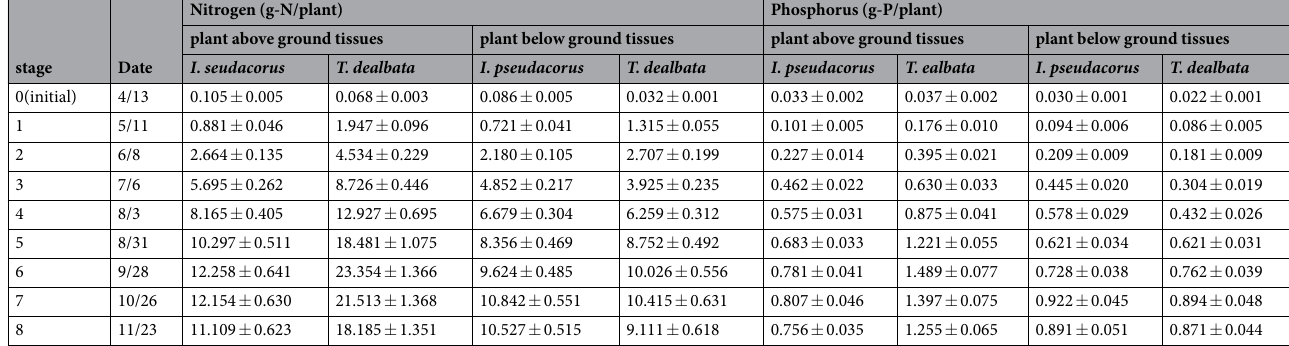
Table 3. Nutrient mass (mean ± SD, n = 3) in single plant above/below ground tissues after 28 days mesocosm experiment in each